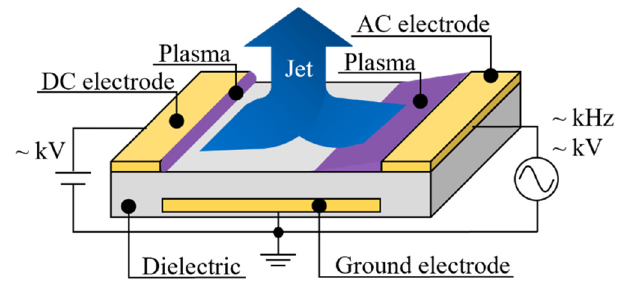
Figure 2. Schematic of a tri-electrode plasma actuator.